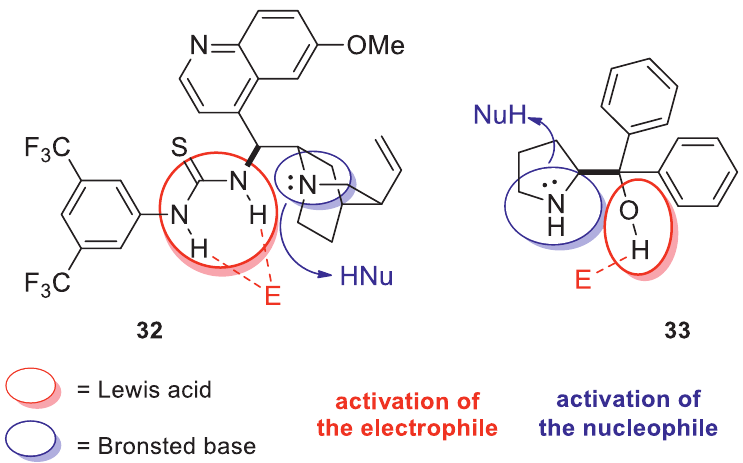
Figure 10 . Examples of bifunctional, non-covalent organocatalysts.